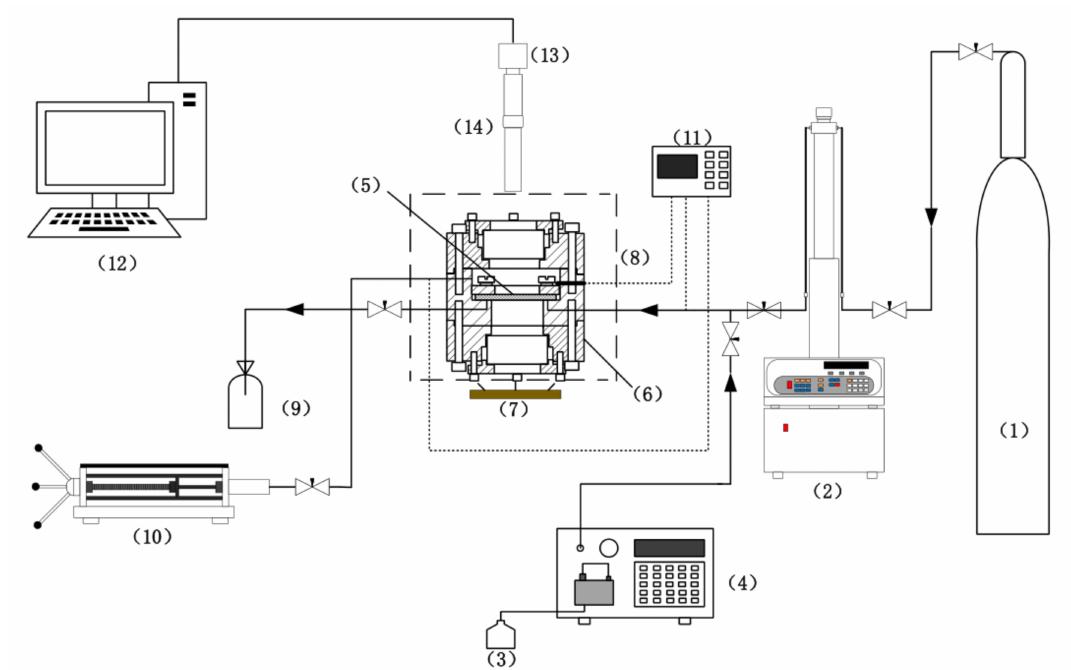
Figure 2. Experimental setup: ( 1 ) methane, ( 2 ) high-pressure microfluidic gas pump, ( 3 ) water tank, ( 4 ) high-pressure microfluidic water pump, ( 5 ) porous glass microfluidic chip, ( 6 ) high-pressure jacket (microfluidic chip holder), ( 7 ) light source, ( 8 ) cooling water bath, ( 9 ) gas/liquid recovery tank, ( 10 ) high-pressure pump, ( 11 ) temperature and pressure acquisition system, ( 12 ) data and image acquisition system, ( 13 ) CCD, ( 14 )